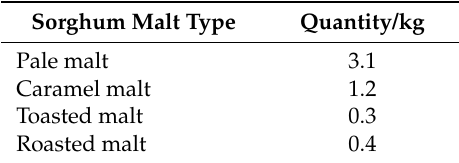
Table 3. Experimental matrix.